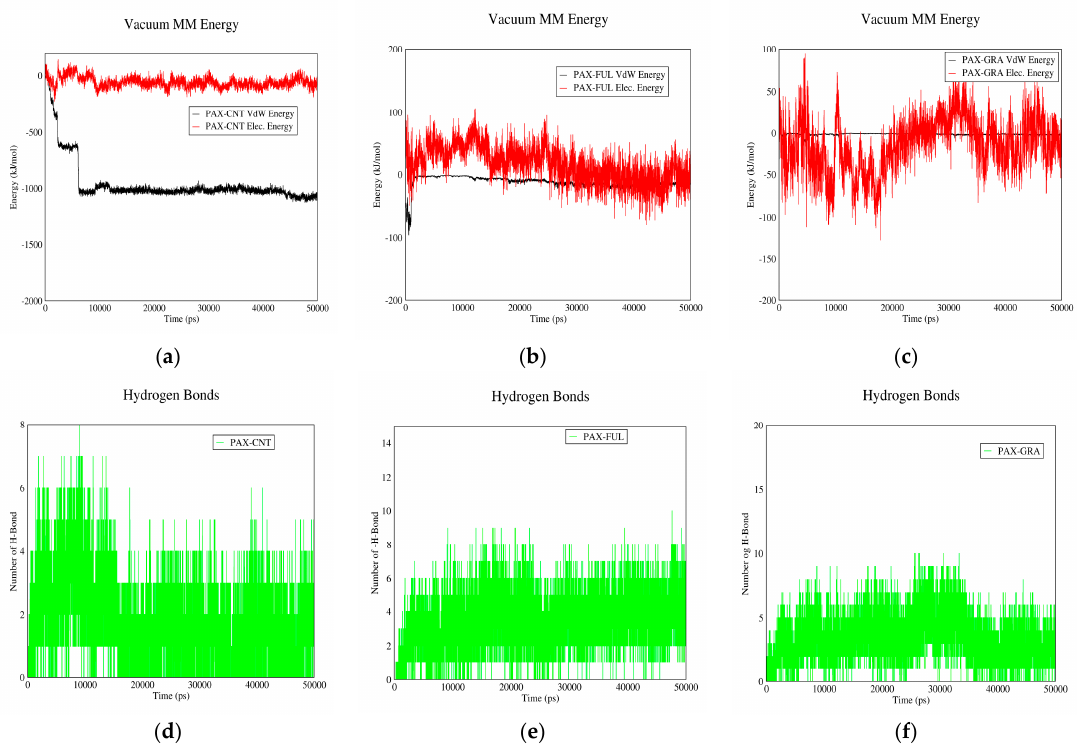
Figure 11. PAX-Carrier interaction energies and hydrogen bonds in neutral pH: ( a ) electrostatic and Van der Waals energies of PAX–CNT interaction versus time in neutral pH; ( b ) electrostatic and Van der Waals energies of PAX–Fullerene interaction versus time in neutral pH; ( c ) electrostatic and Van der Waals energies of PAX–GO interaction versus time in neutral pH; ( d ) the number of hydrogen bonds between PAX and CNT versus time in neutral pH; ( e ) the number of hydrogen bonds between PAX and fullerene versus time in neutral pH; ( f ) the number of hydrogen bonds between PAX and GO versus time in neutral pH.